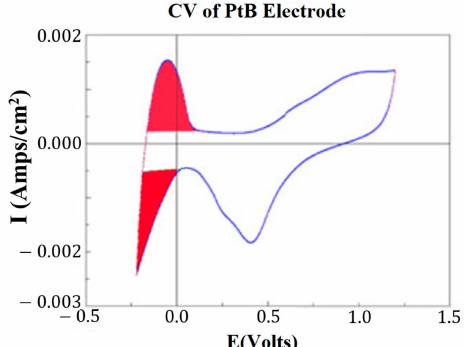
Figure 2. CV of platinum black electrode. Image is taken from the program CorrView (Scribner Associates). The CV is graphed as I (current) vs. E (voltage). The areas under the curve designated in red are averaged together to determine the appropriate Q value. Charge is determined by integrating over this